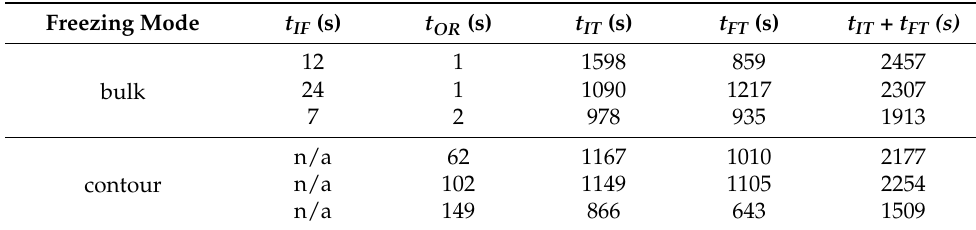
Table 3. Numerical data accounting the time needed for recalescent freezing ( t IF ), out-of-resonance events ( t OR ), initial ( t IT ), and full thawing ( t FT